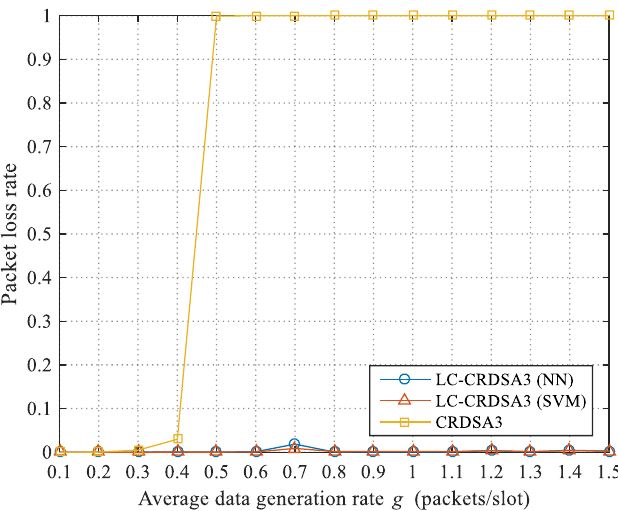
Figure 8. Comparison of packet loss rates between LC-CRDSA3 and CRDSA3.